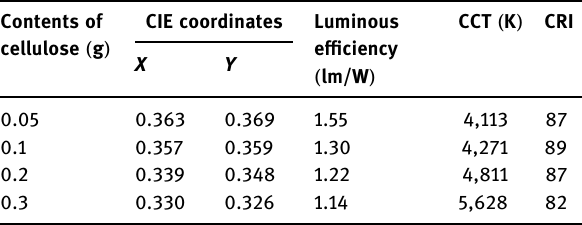
Table 2: Performance of WLEDs fabricated with di ff erent contents